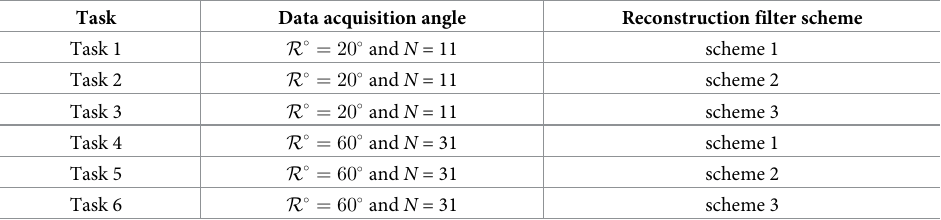
Table 3. Detection tasks for different data acquisition angles and reconstruction filter